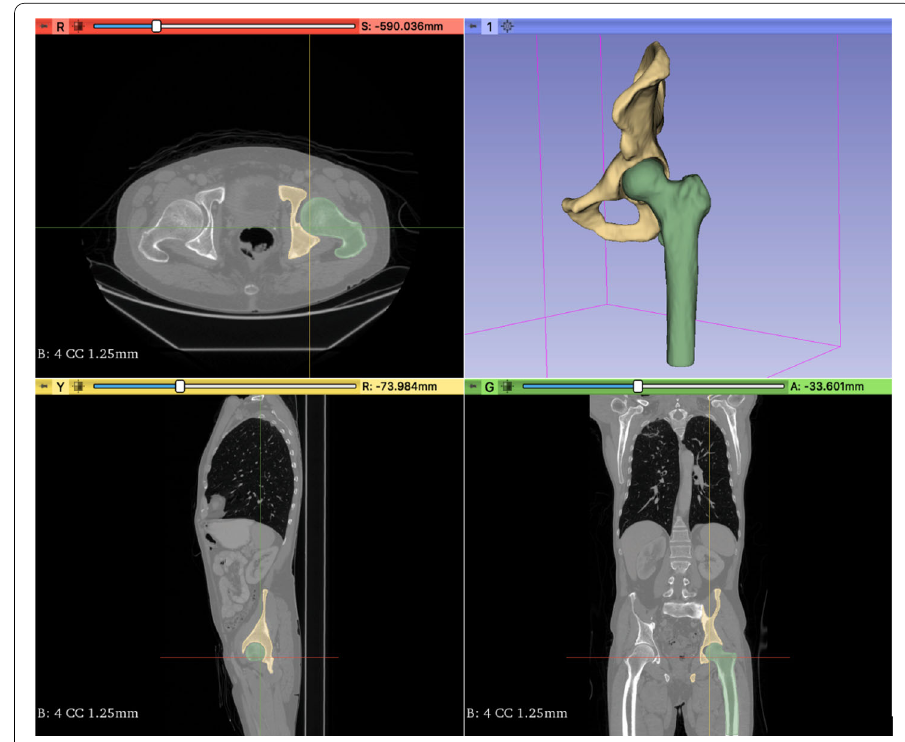
Fig. 2 The different scene views of the hip joint and the calculated 3D model of both the femur (green) and the pelvis (yellow) bones in 3D slicer [1]